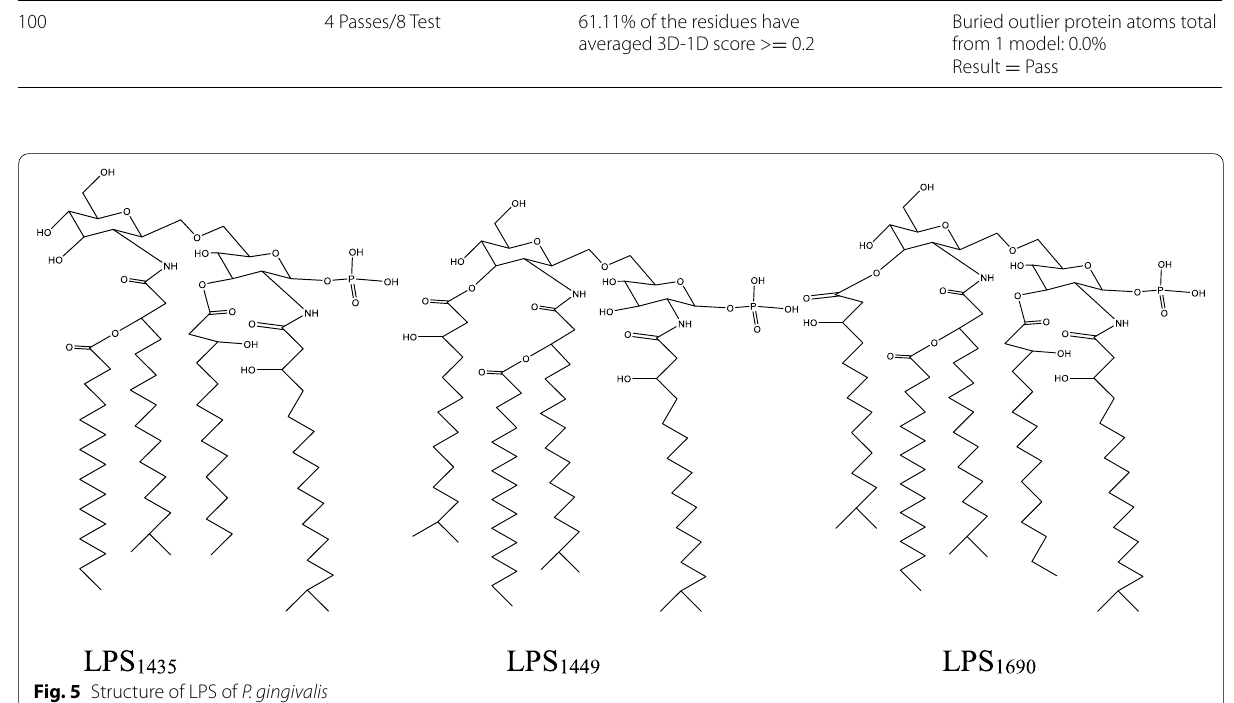
Table 6. The binding energy (Kcal/mol), inhibition con- stant (Ki), and hydrogen bonds formed were used to eval- uate the binding affinity of β-defensin 1 with LPS. The binding energies of LPS 1435 , LPS 1449 , and LPS 1690 with Kcal/mol, and 8.67 Kcal/mol respectively. LPS 1690 had − the best binding energy among the three LPS structures.